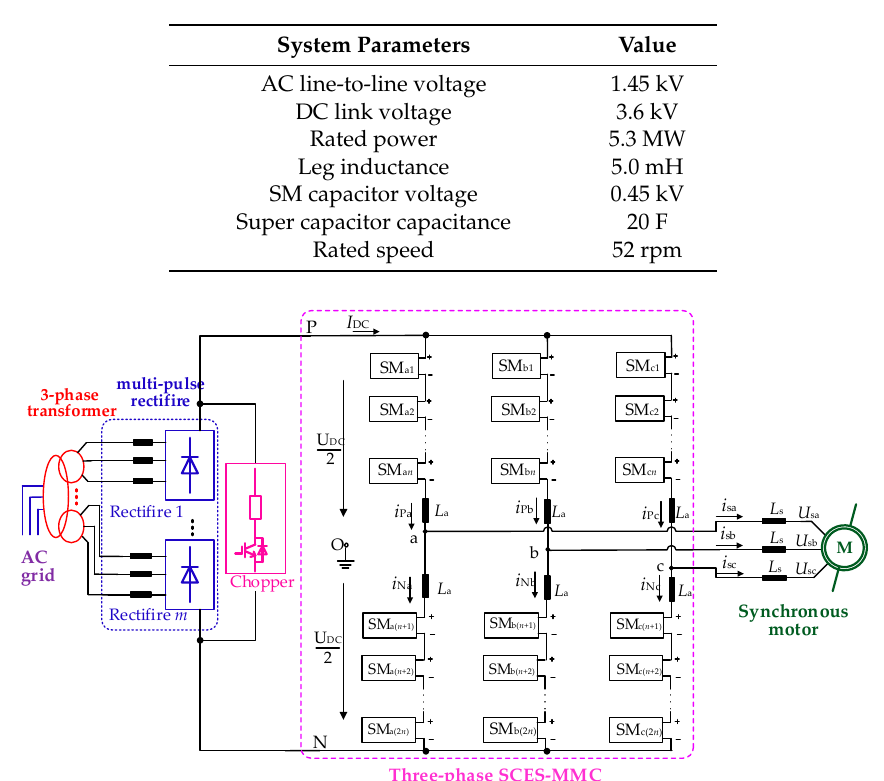
Table 2. Simulation parameters of SCES-MMC.